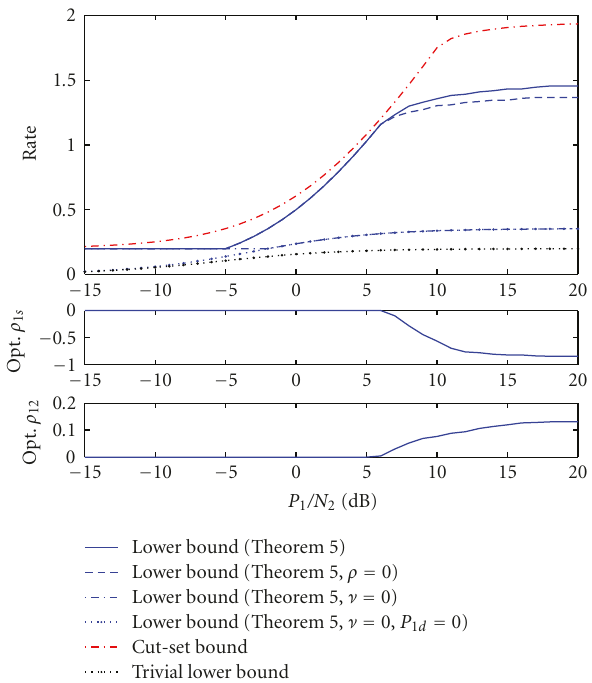
Figure 6: Lower bounds on the capacity of the state-dependent general Gaussian RC with informed source (28), together with the (cid:20) 1 − ξ − ρ 2 and ρ 1 s : = ρ for the lower bound maximizing ρ 12 = (29). Numerical values are: P 1 = 5dB, P 2 = 20dB, Q = 10dB, N 3 =